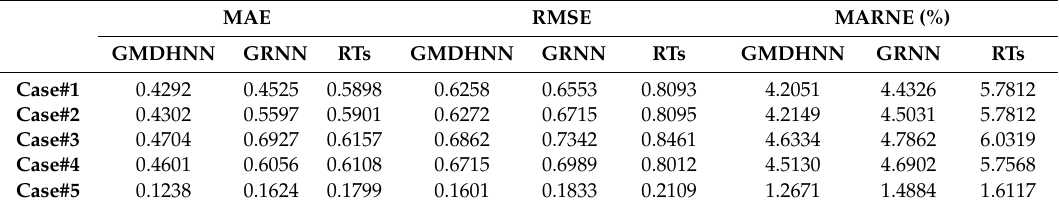
Table 5. Evaluation of GMDH, GRNN, and RTs considering the 10-min-ahead horizon.